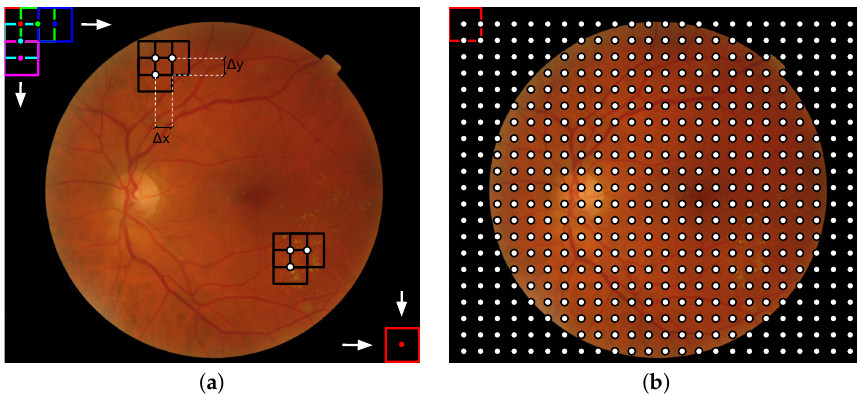
Figure 2. Illustration of the local analysis in fundus images: ( a ) Visual representation of how the sliding window of dimensions N w × N w loops a fundus image and ( b ) the resulting image grid composed by the centers of the sliding window in each position. This process is equivalent to a dense sampling. For the representation N w = 64 and ( ∆ x , ∆ y ) = (32,32) were used.